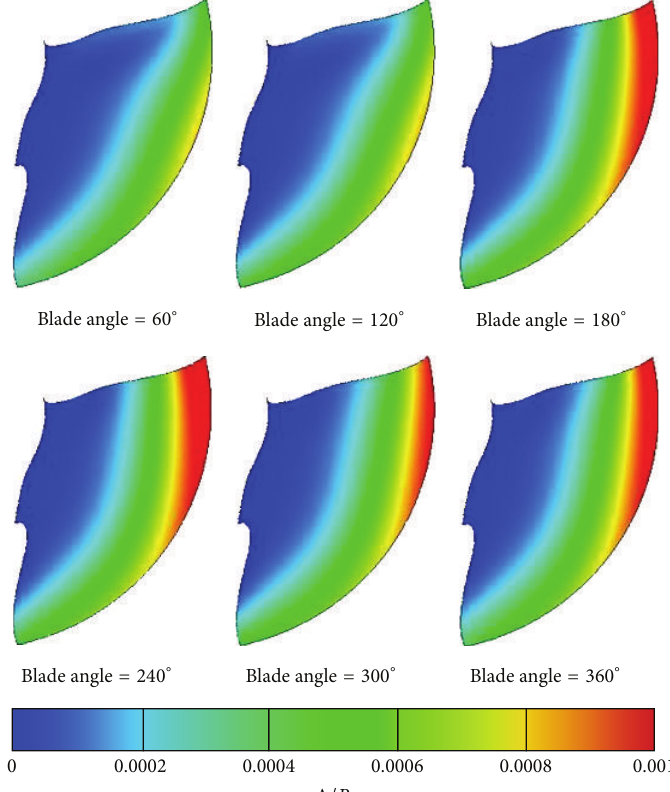
Figure 21: Normalized deformation contours for the referenced rotor blade at various blade angles along one revolution ( 𝑅 = 0.85 m).